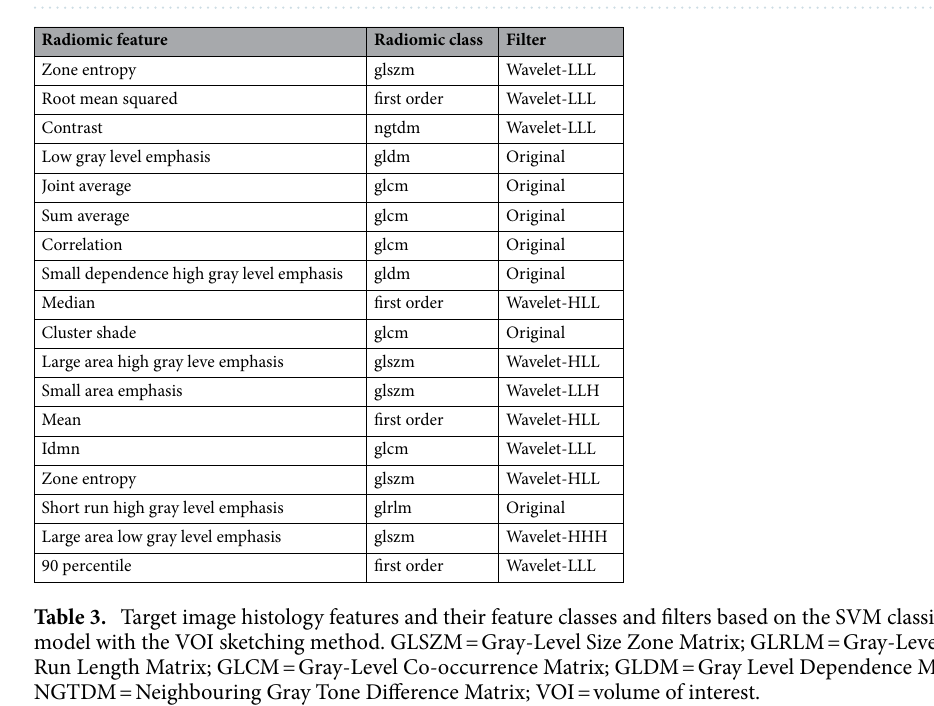
Figure 3. Feature selection using LASSO logistic regression. ( a ) The coefficients of the remaining eighteen features in the VOI sketching method. ( b ) The regression coefficients of LASSO in the VOI sketching method. ( c ) The coefficients of the remaining eighteen features in the three-layer sketching method. ( d ) The regression coefficients of LASSO in the three-layer sketching method.